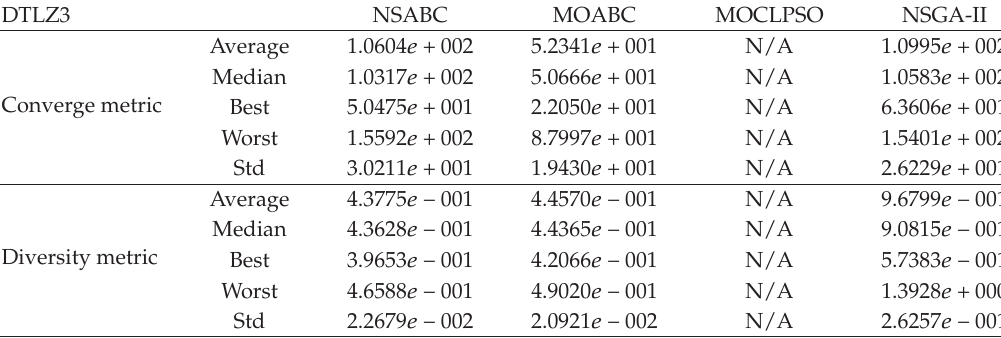
Table 19: Comparison of performance on DTLZ3 after 10000 FEs.